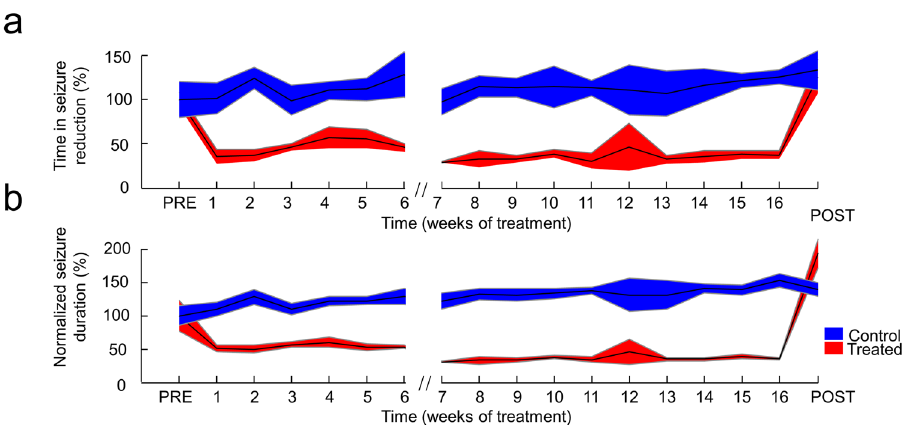
Figure 5. Sustained efficacy of the seizure suppression during the four-month long stimulation. (a and b) Results of an extended 4 months long treatment are similar to those obtained during the 6 weeks protocol (Fig. 4b and c), both for the Time in Seizure ( a ) and average seizure duration ( b ). Shaded area represents ± SD. (Control period at the end of the 6 week treatment is